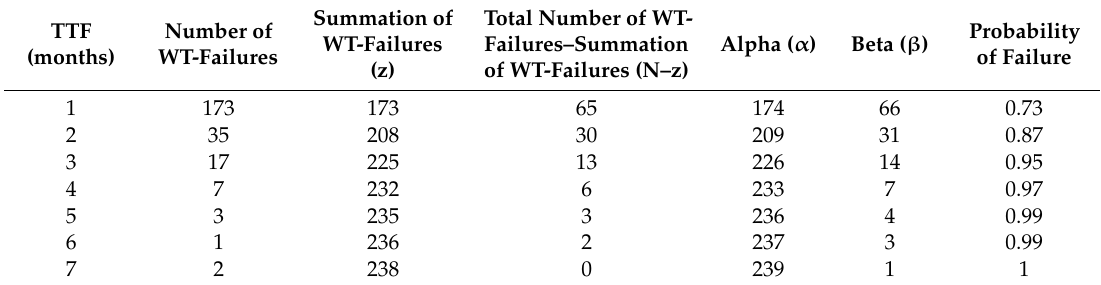
Table 2. An example of calculations for monthly probability of